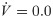
Performance of the antithetic controller with transporter mediated compensatory flux (Eqs 21–27).Phase 1: constant volume V and constant k3. Initial concentrations and rate constant values: V0 = 25.0, V˙=0.0, A0 = 0.0, E1,0 = 0.0, E2,0 = 0.0, M0 = 1 × 105, O0 = 1 × 105, k2 = 1.0, k3 = 2.0, k3˙=0.0, k4 = 10.0, k5 = 1 × 10−6, k6 = 20.0, k7 not used, k8 = 20.0, k9 = 1 × 10−6. The controller keeps A at its theoretical set-point at Asettheor=k8/k4=2.0 (Eq 28). Phase 2: rate constants remain the same as in phase 1, but V increases linearly with V˙=2.0, while k3 remains constant at k3 = 2.0. The controller shows an offset below Asettheor with Ass = 1.11 in agreement with Eq 29. Phase 3: V continues to increase while k3 increases linearly with k3˙=1.0. As indicated by Eq 29 the controller breaks down and A goes to zero.